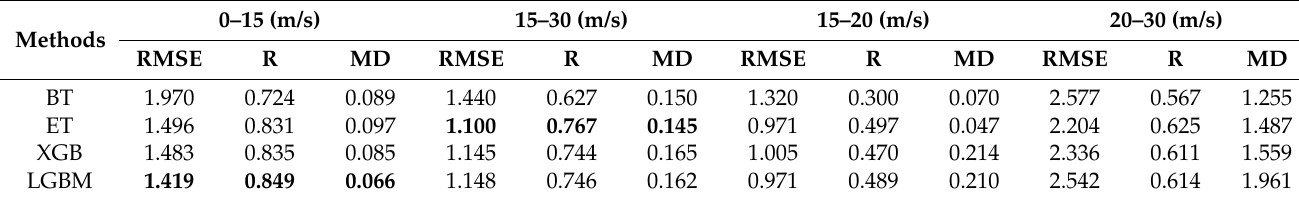
Figure 7. Results of wind speed retrievals based on regression trees methods. The subgraphs in the first row represent the retrieval results in low wind speed, while those in the second row represent the retrieval results in high wind speed. The black line shows the 1:1 performance line. Table 4. The retrieval performance of each regression tree models.